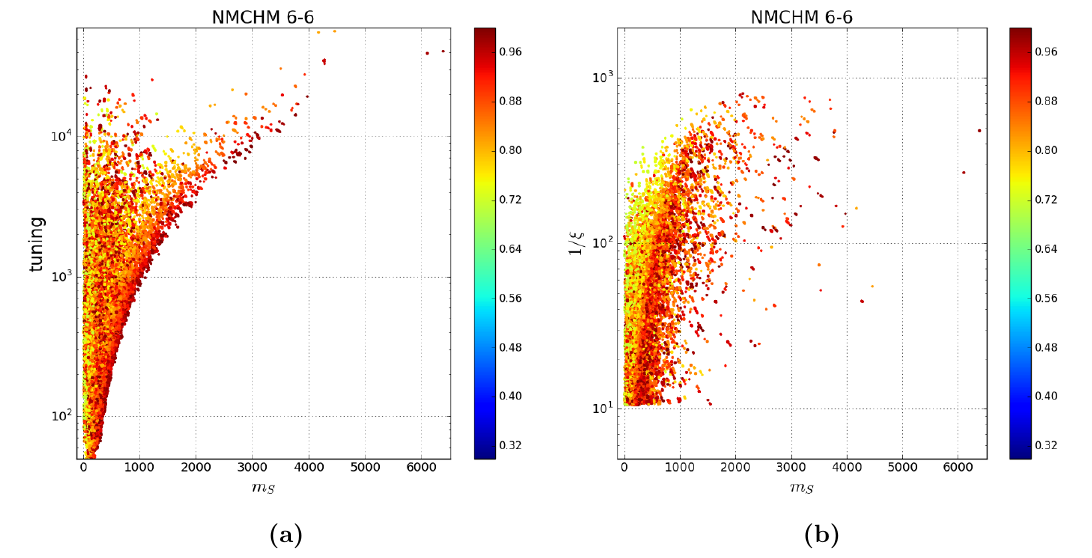
Figure 14. The singlet mass (in GeV) vs (a) higher order tuning and (b) naive tuning with sin (cid:18) as the third dimension, for points with (cid:18) 2 f (cid:25)= 4 ; (cid:25)= 2 g .